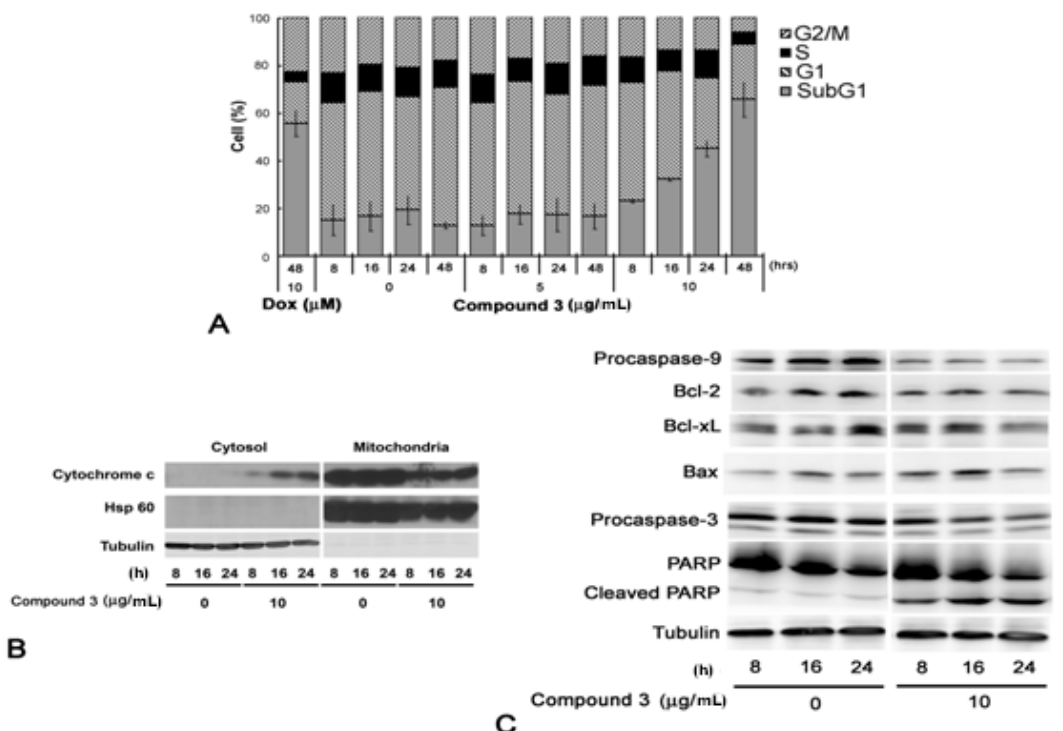
Figure 4. Mechanism of compound 3 -induced cell